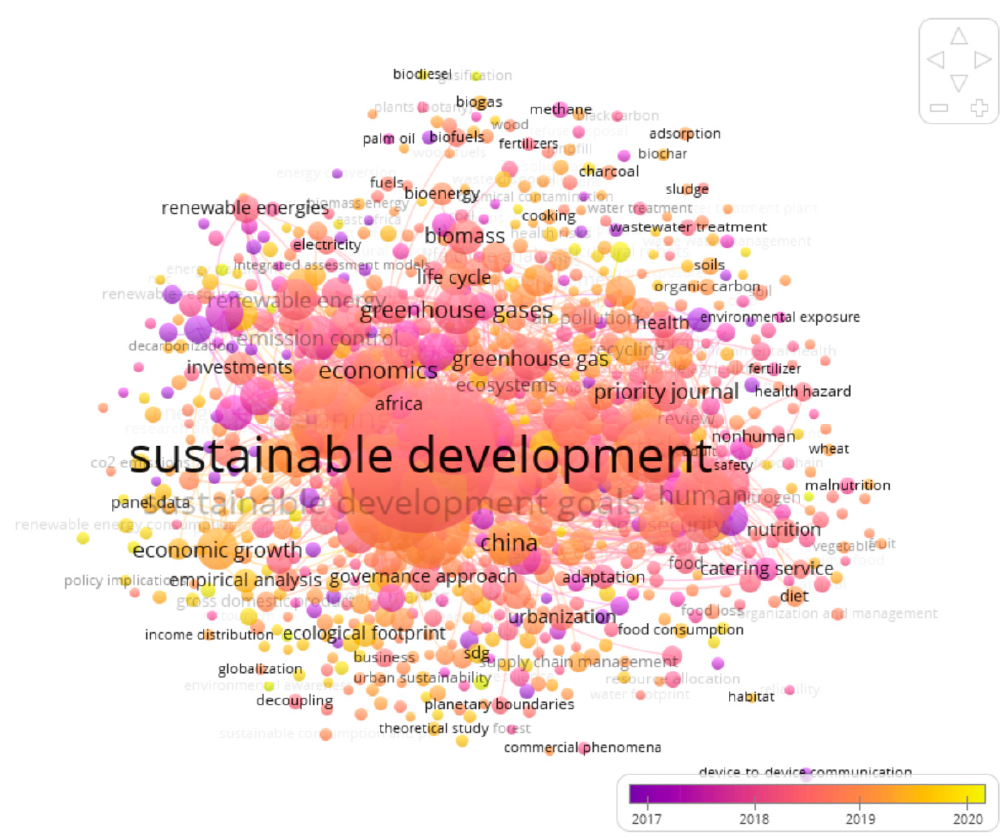
Figure 2. Key themes and topics highlighted in the literature.